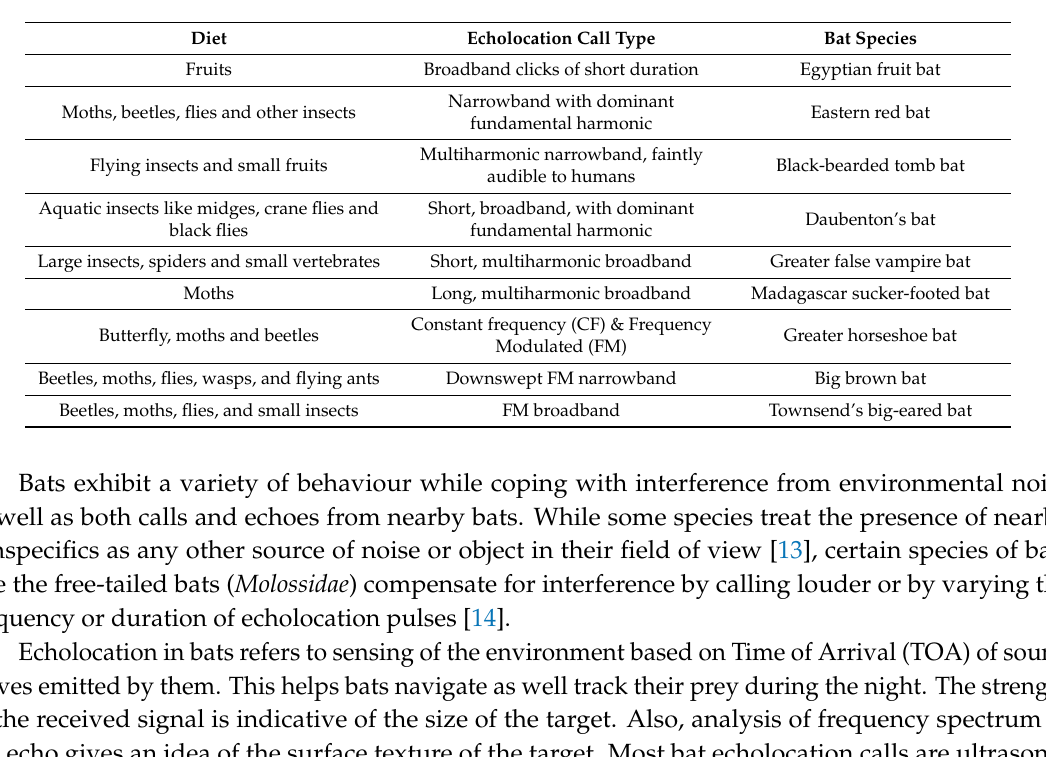
Table 1. Echolocation call types for different bat species based on diet [11,12].